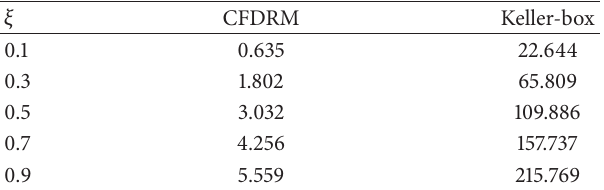
Table 3: Computational times for Example 2 at various values of 𝜉 . 𝜉